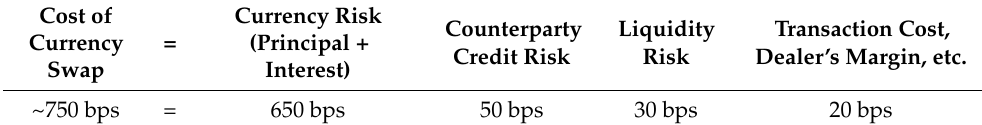
Table 3. Cost components of a commercial swap, in basis points (bps) [13]. Both currency risk and counterparty credit risk components are derived from the cost provided by a commercial